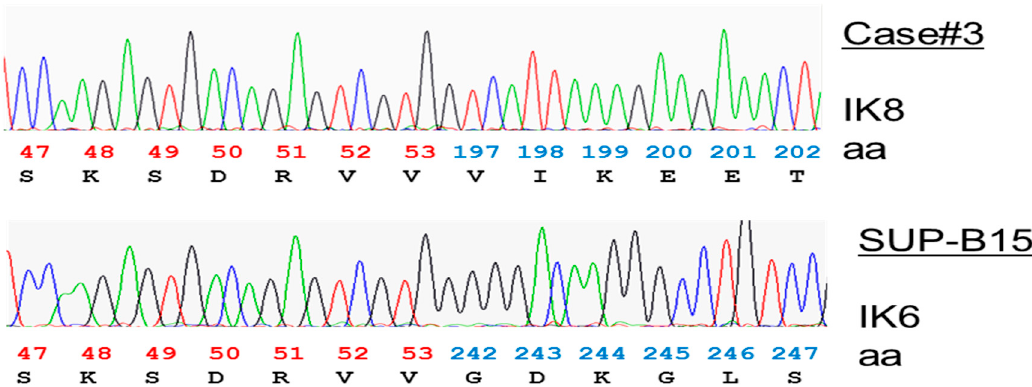
Figure 2. Sequencing confirmation and amino acid translation of the Ik-8 and Ik-6 PCR products. Sanger sequencing was performed on cloned Ik-8 and Ik-6 isoforms in a clinical sample (case 3565, Table 1) and lymphoblastic cell line (SUP-B15), respectively. The colored numbers below the sequencing traces were predicted codons and corresponding amino acids of IKZF1 (NC_000007.14).